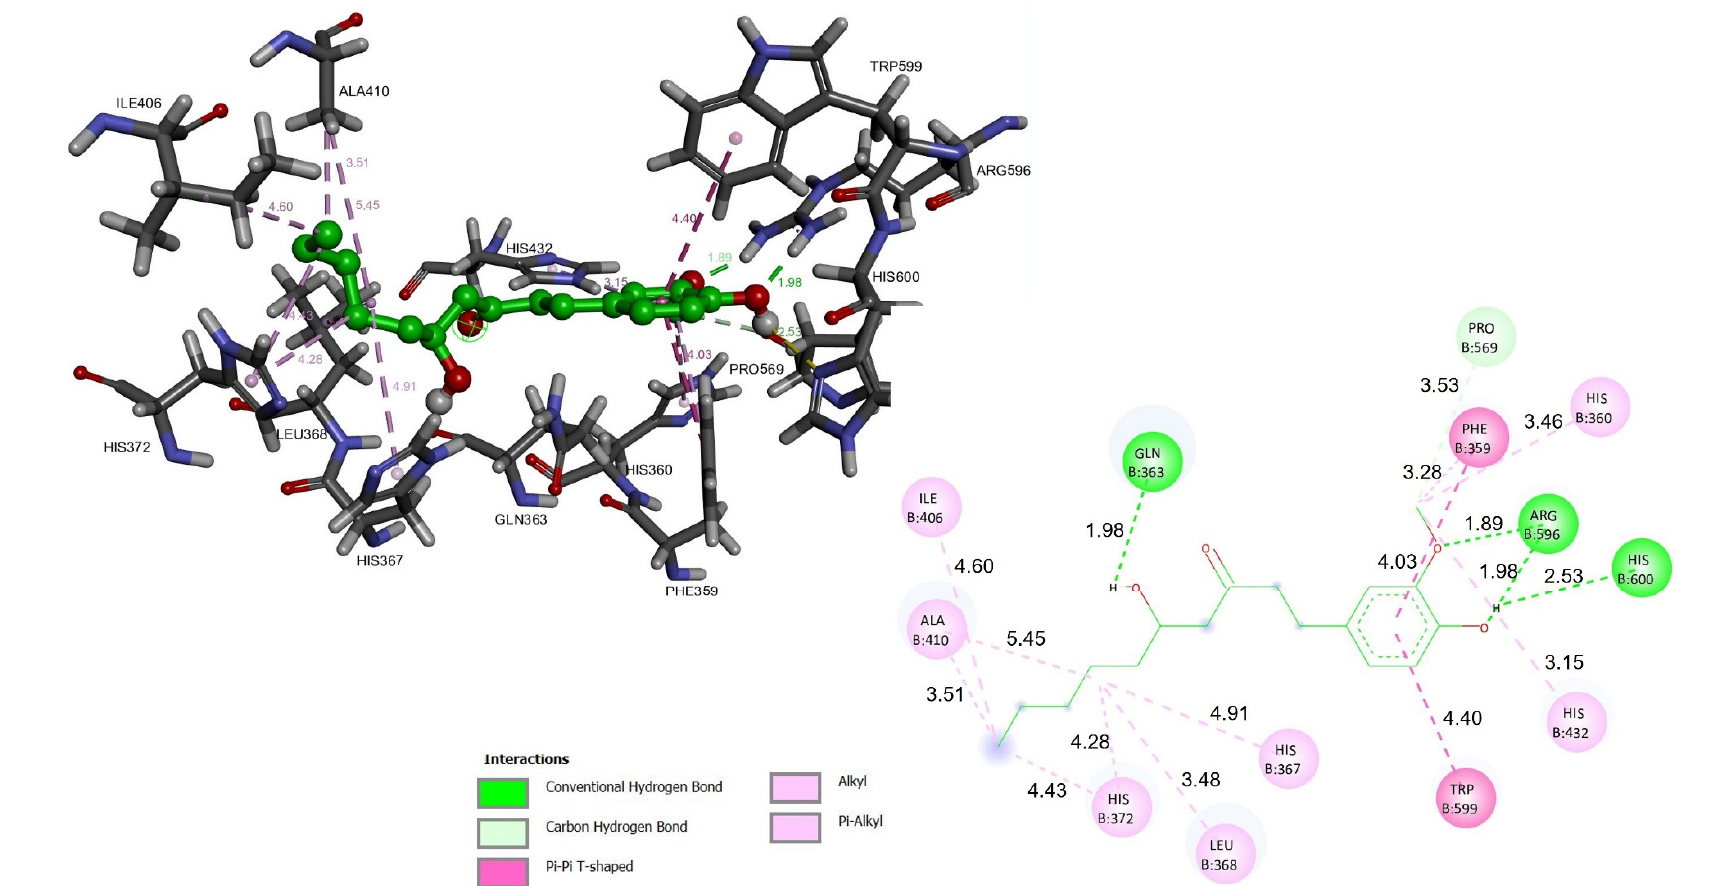
Figure 2. Molecular docking of 6-gingerol with 5-LOX (PDB:6N2W). The main residues involved in the protein–ligand interaction ( left ) and the main interactions involved in the protein–ligand binding ( right ) of 6-gingerol; distances are shown as Å over the lines.